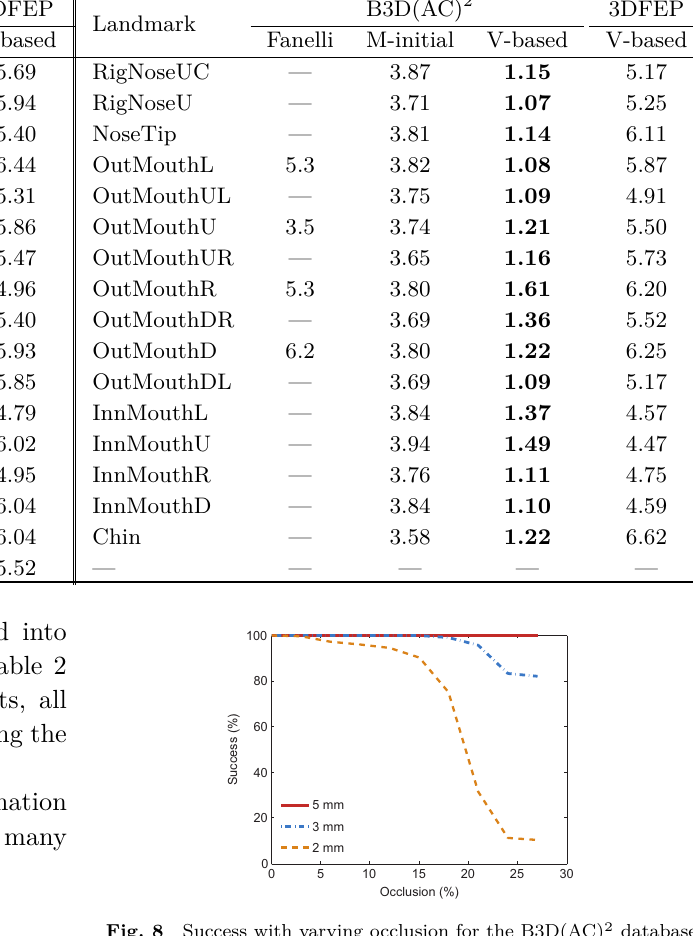
Fig. 8 Success with varying occlusion for the B3D(AC) 2 database.